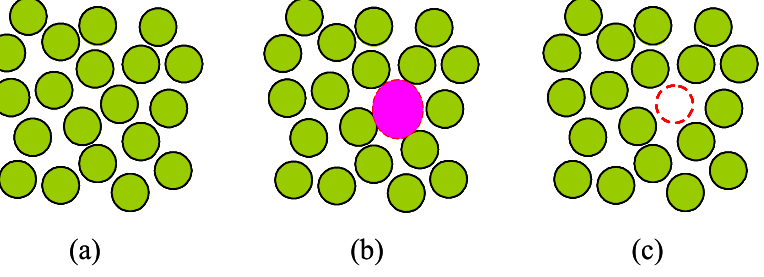
Figure 1. Two-dimensional diagram for an ensemble of atoms in liquids or glasses: ( a ) traditionally, the system was considered as a many-body problem; ( b ) in Lennard-Jones’ approach, the potential energy of the field within an atomic cell (dashed shadowed circle) was integrated; ( c ) in our liquid model, all the forces exerted on each of the atoms is estimated by using the energy needed to produce a vacancy (dashed empty